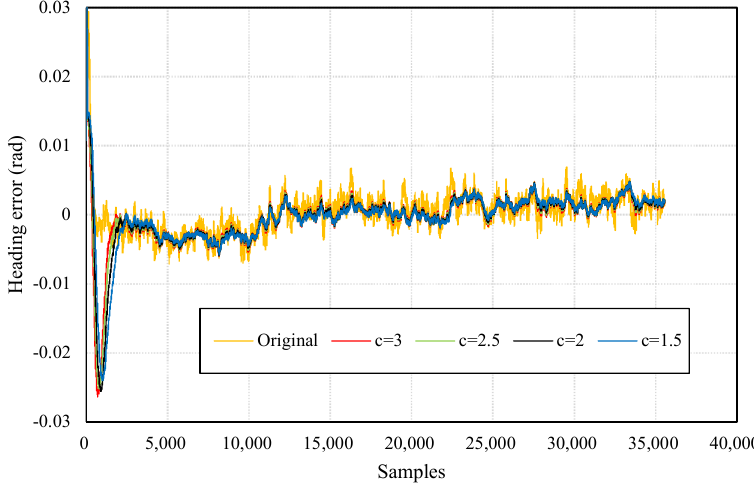
Figure 4. Heading errors with respect to different values of the robust parameter c.